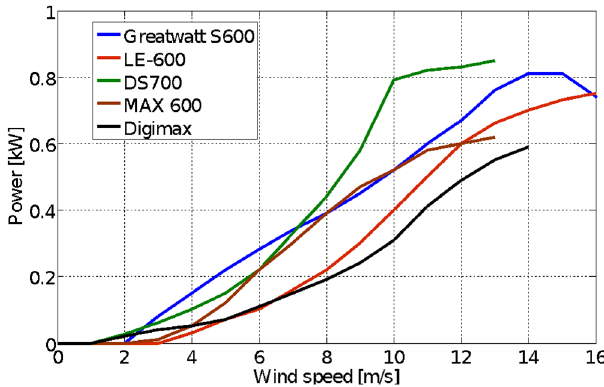
Figure 5. Power curves for the 0.6 kW turbines, [23].